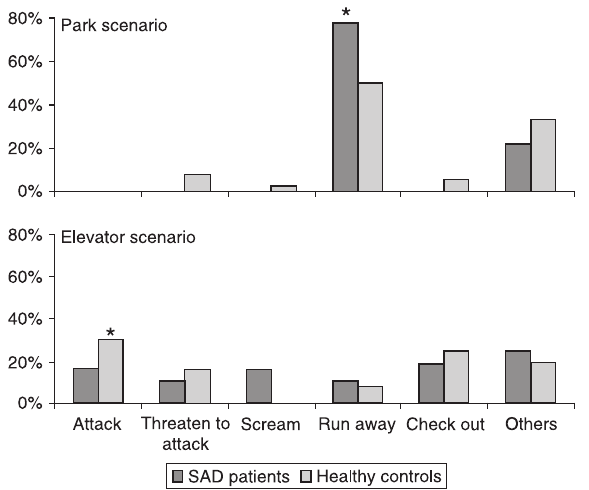
Figure 2. Frequency of first-choice responses to the Park and Elevator scenarios by SAD male patients (N = 36) and matched healthy controls (N = 36). SAD = social anxiety disorder. *Signifi - cant differences between groups (P < 0.05, Fisher exact